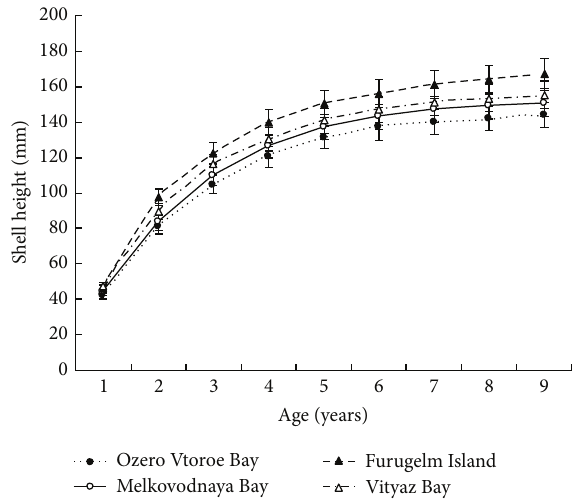
Figure 5: Patinopecten yessoensis . Growth of the scallops in the studied sites. Data are mean ±